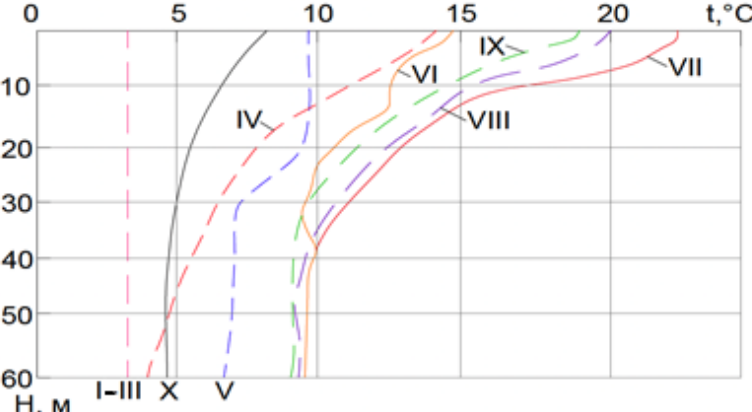
Figure 11. History of dam construction and reservoir impoundment schedule.